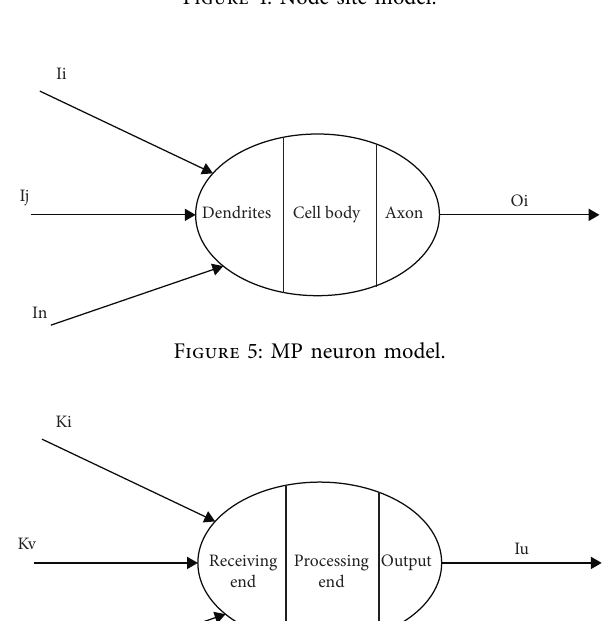
Figure 6: Neuron model of route.